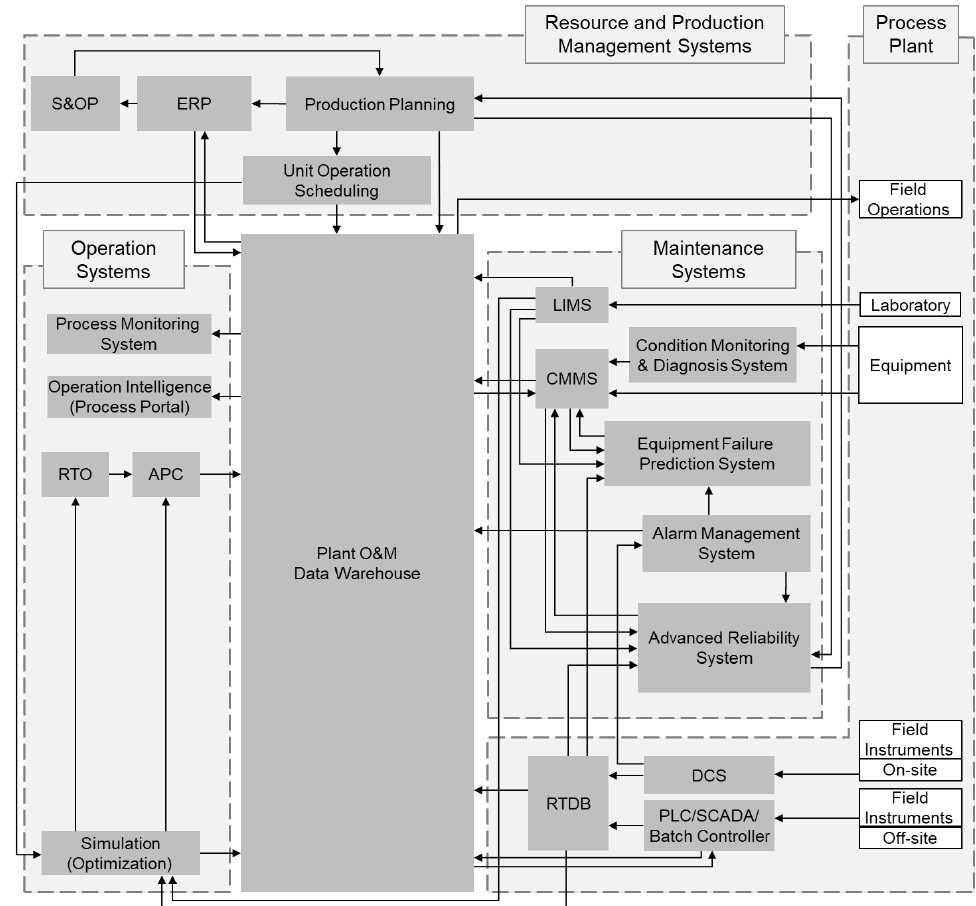
Figure 2. Configuration of O&M systems in process plants.